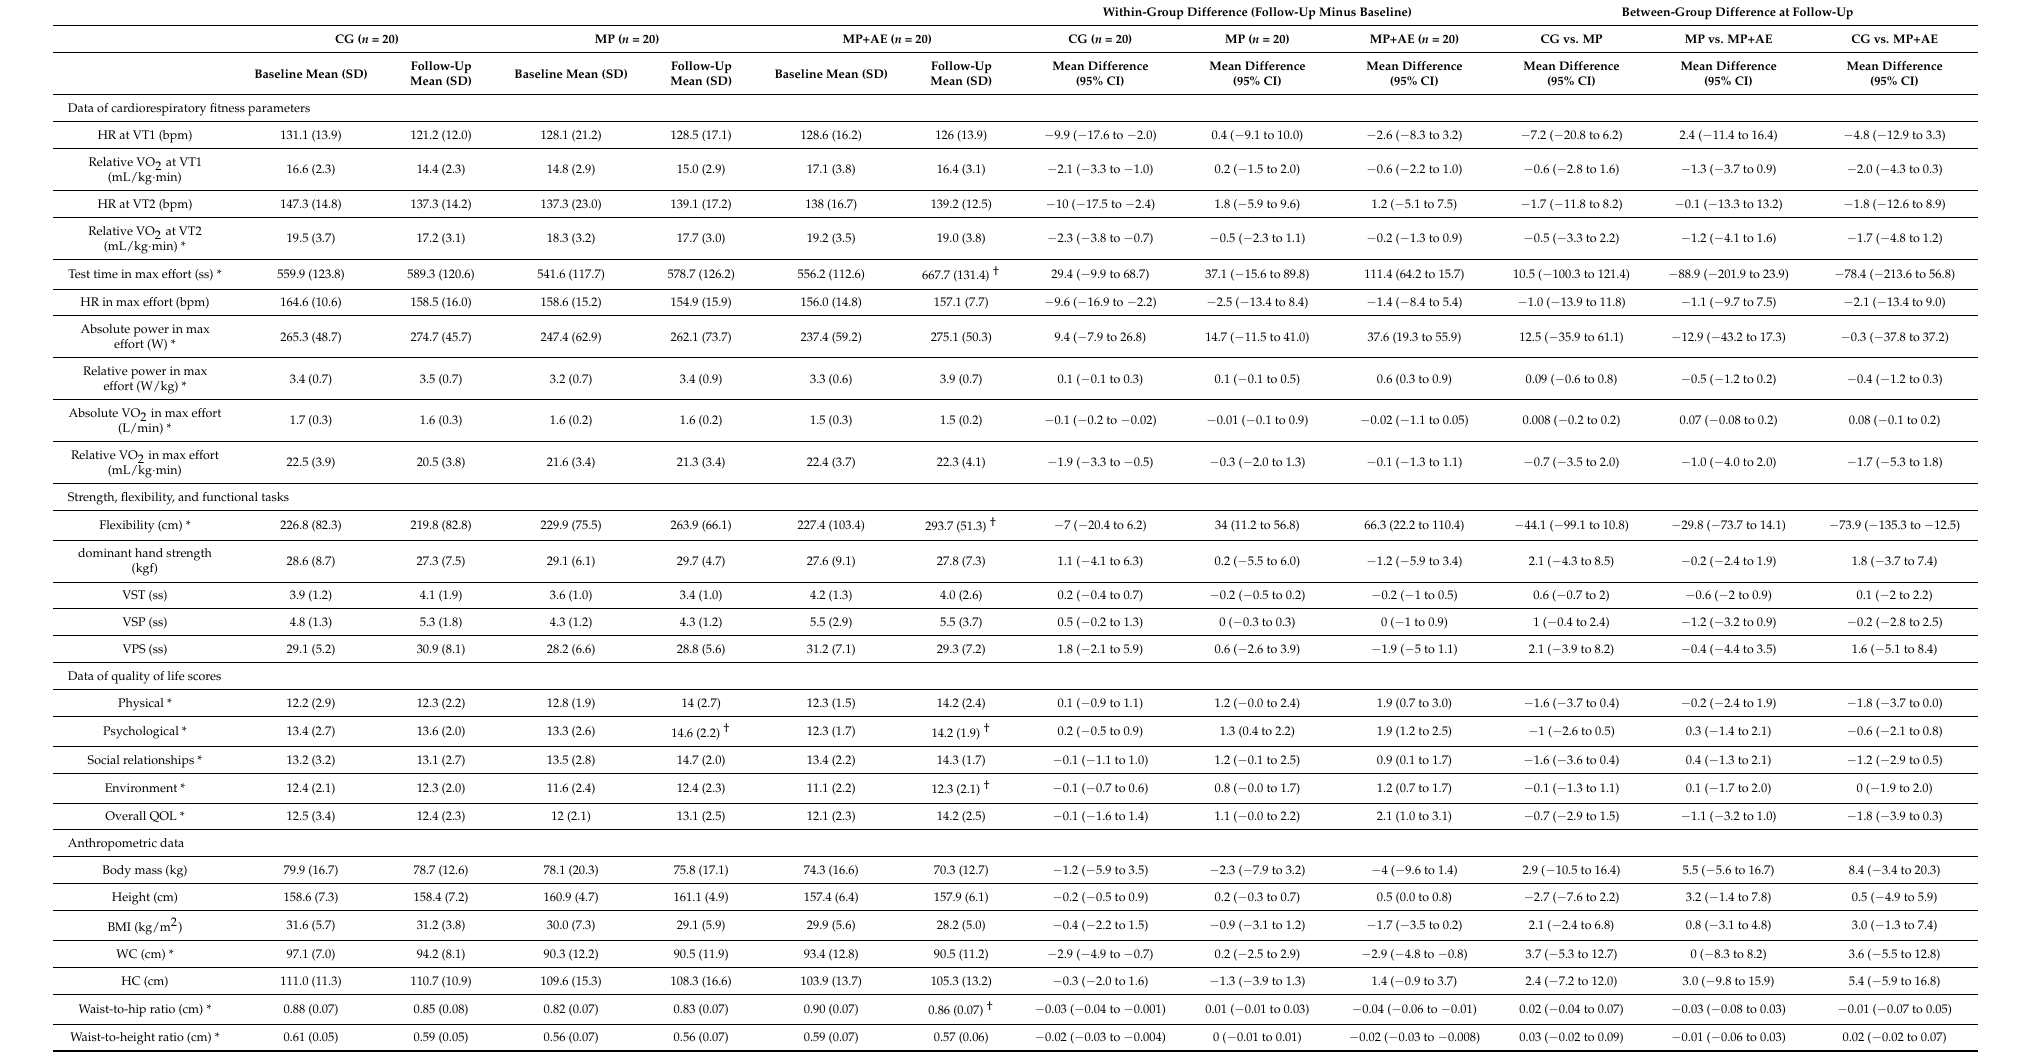
Table 3. Mean (SD) of groups and mean (95% CI) within and between-group differences for the